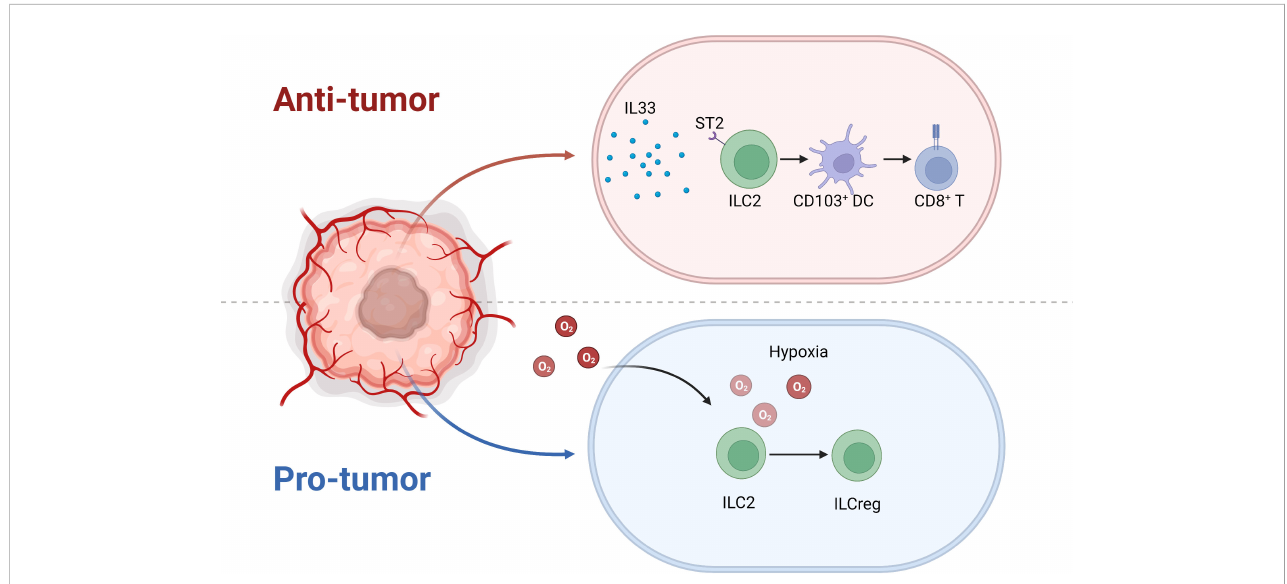
FIGURE 6 Under IL33 stimulation, ILC2 recruits CD103 + DCs and prime CD8 + T cells to inhibit tumor progression. Nonetheless, the extreme hypoxic environment of pancreatic cancer induces ILC2 conversion to